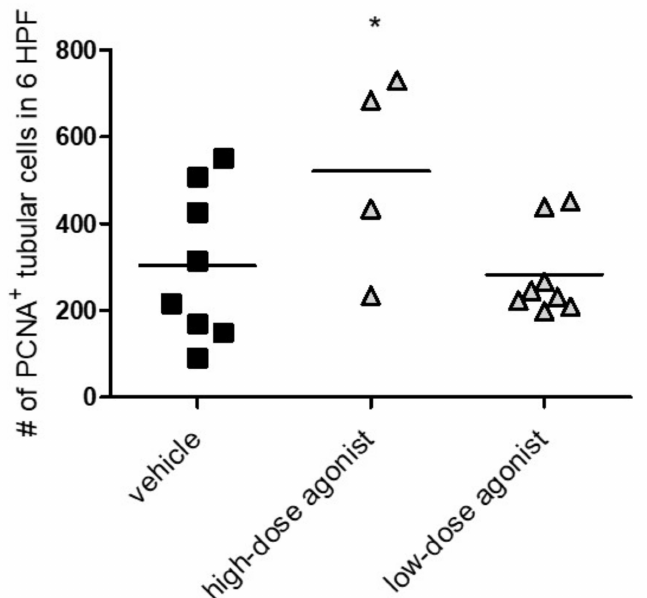
Figure 6. EP4 agonist-treated mice showed increased proliferation of tubular cells in vivo. Fourteen days after NTS induction, mice treated with vehicle, high-dose EP4 receptor agonist or low-dose EP4 receptor agonist were evaluated for PCNA+ tubular cells per six high power fields (HPF). Means are indicated by horizontal lines. Statistical significances are provided compared to vehicle-treated mice (* p ≤